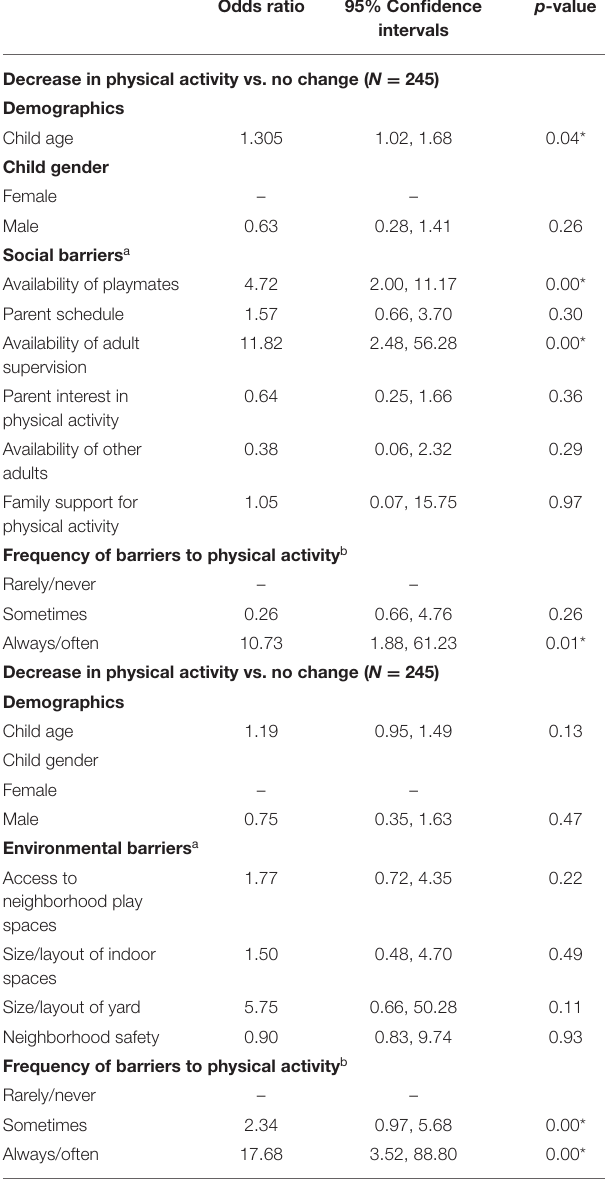
TABLE 2 | Logistic regression associations of social and environmental barriers with decreased child physical activity during COVID-19 stay-at-home orders. Odds